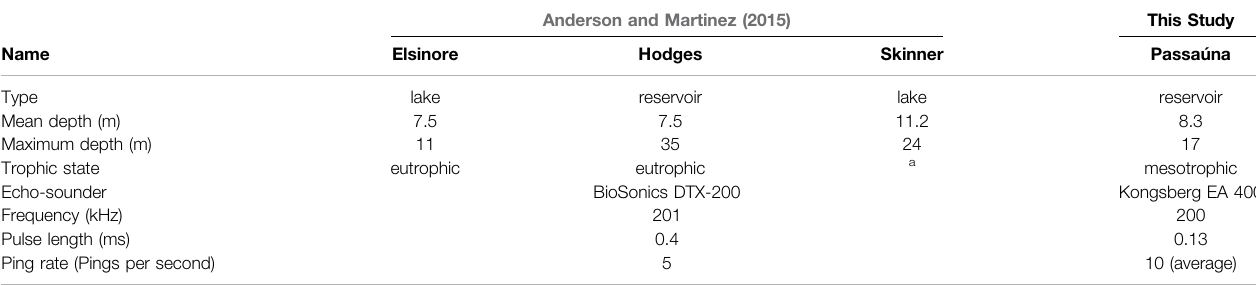
TABLE 1 | Summary of the study site characteristics and echo-sounder details of the study by Anderson and Martinez (2015) for which an empirical relationship between maximum backscatter strength and sediment gas content was established, and the corresponding information for Passaúna